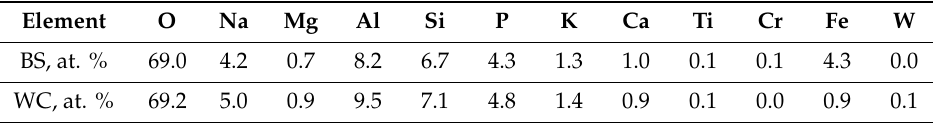
Table 3. Elemental composition of the wear scars for plasma electrolytic oxidation (PEO) coating